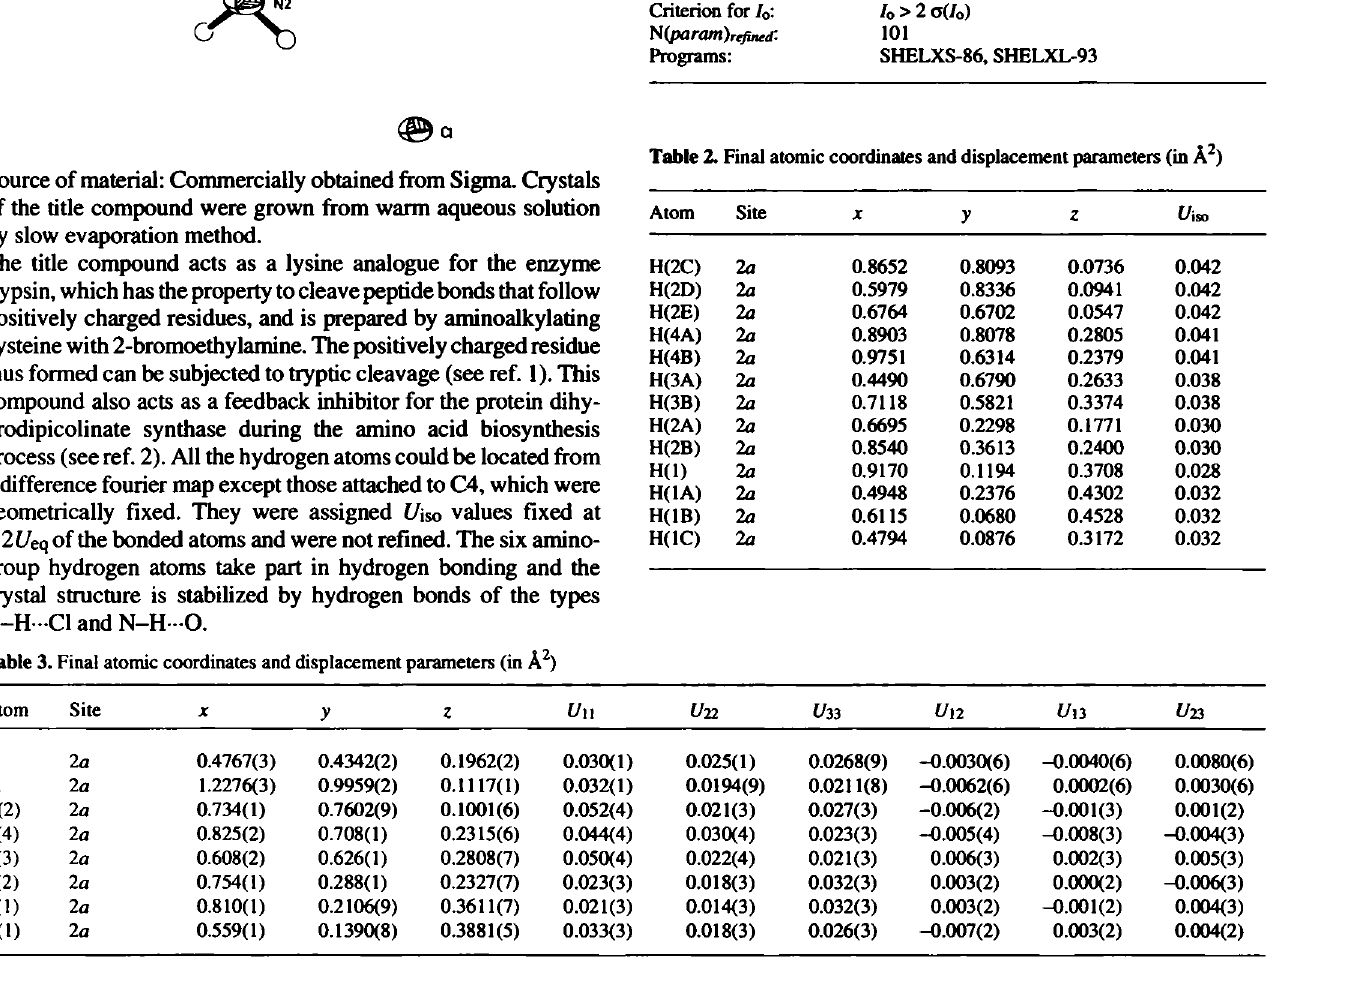
Table 3. Final atomic coordinates and displacement parameters (in Â^)